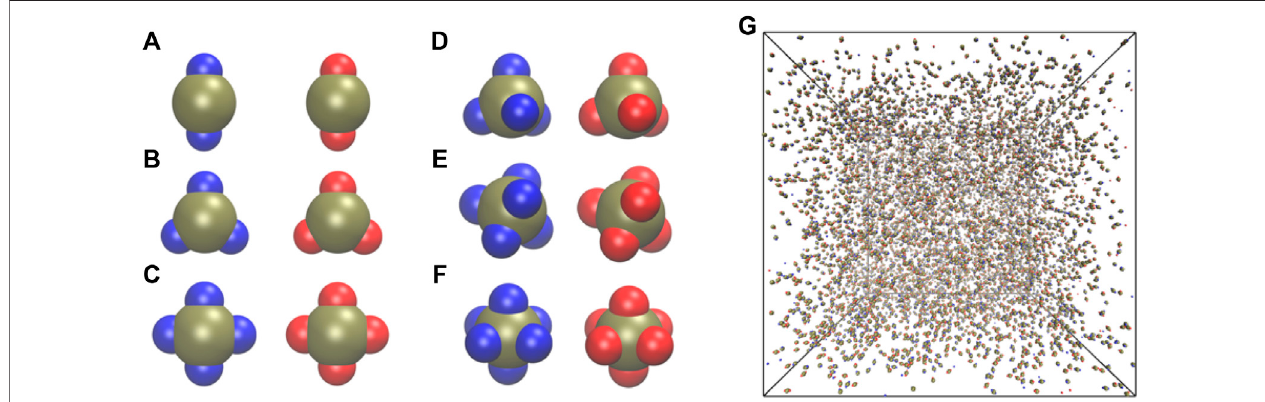
FIGURE 1 | Snapshots of particle geometries studied in this work: (A) Dumbbell ( S DB 2 ) , (B) Trigonal planar ( S TP 3 ) , (C) Square Planar ( S SP 4 ) , (D) Tetrahedral ( S TH 4 ) , (E) Trigonalbipyramidal ( S TB 5 ) ,and (F) Octahedral ( S OC 6 ) .Theseedsarecoloredtan,thepositively-chargedlobesarecoloredblue,andthenegatively-chargedlobesare coloredred.Tworepresentationsofeachparticleinthepanels (A – F) indicatethata1:1mixtureofthesametypeofparticleswasstudied. (G) Asnapshotofthesimulation domain showing a typical randomized initial con fi